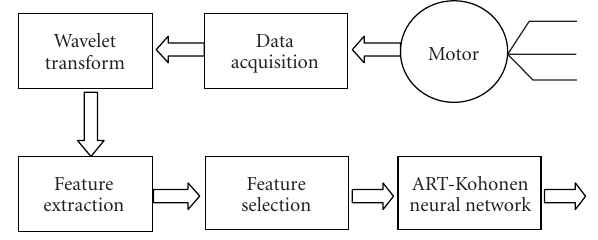
Figure 1: Architecture of the diagnosis system for induction mo-